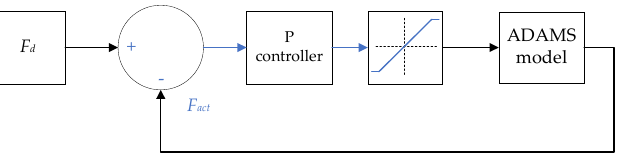
Figure 6. Force P-controller used to control the closing of robotic grippers ’ fingers. F d is the desired value of contact force between the robotic grippers finger and the object, and F act is the actual contact force.